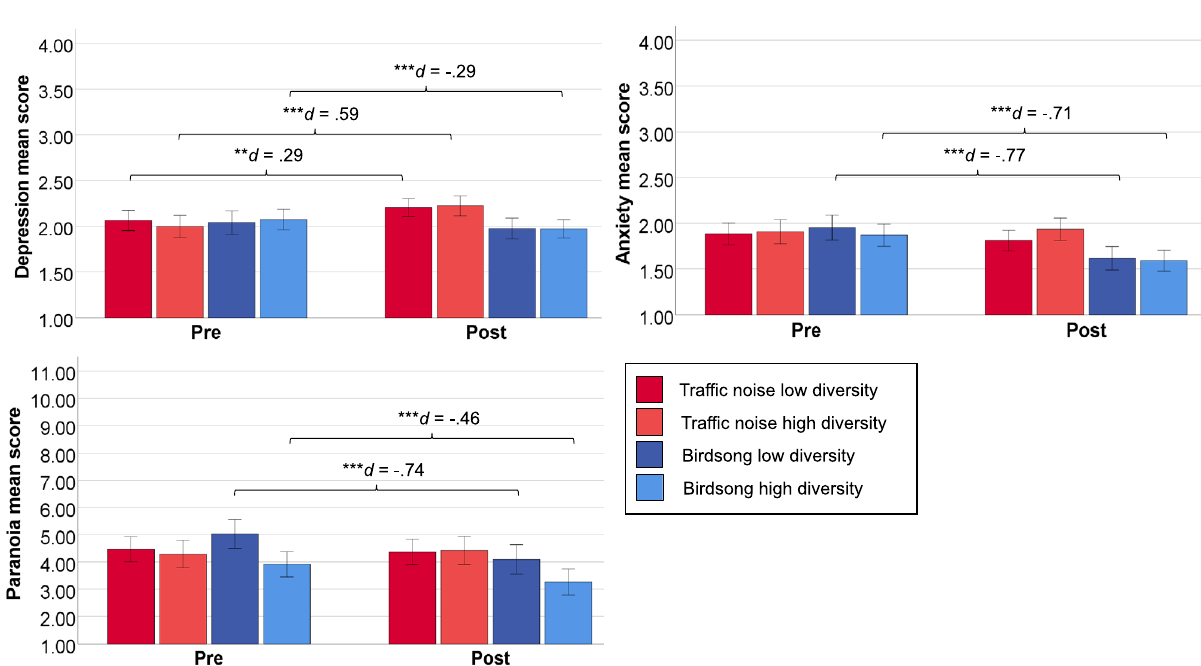
Figure 1. Within-group changes in mood and paranoia for all variables of interest. Y-axes have been formatted to reflect the possible data range. The interpretation of scores corresponds to the Likert-scale of the respective measure. Between-group differences (at baseline) and exact descriptives (means and standard deviations) for pre- and post-tests can be found in Supplementary Table 2. Paired t-test statistics for changes within groups in mood (anxiety, depression) and paranoia can be found in Supplementary Table